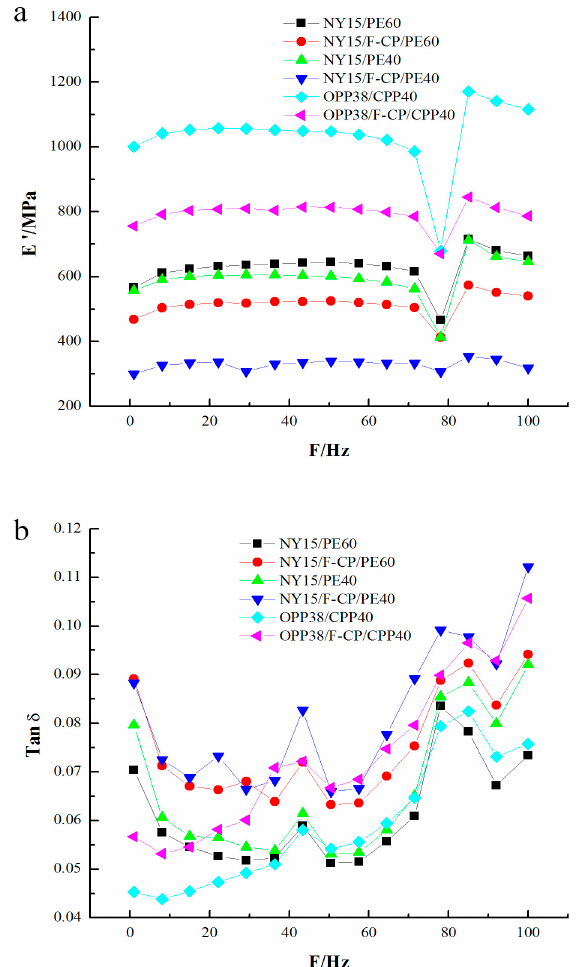
Figure 4. ( a ) Dynamical storage modulus; ( b ) tangent of loss angle of six composite